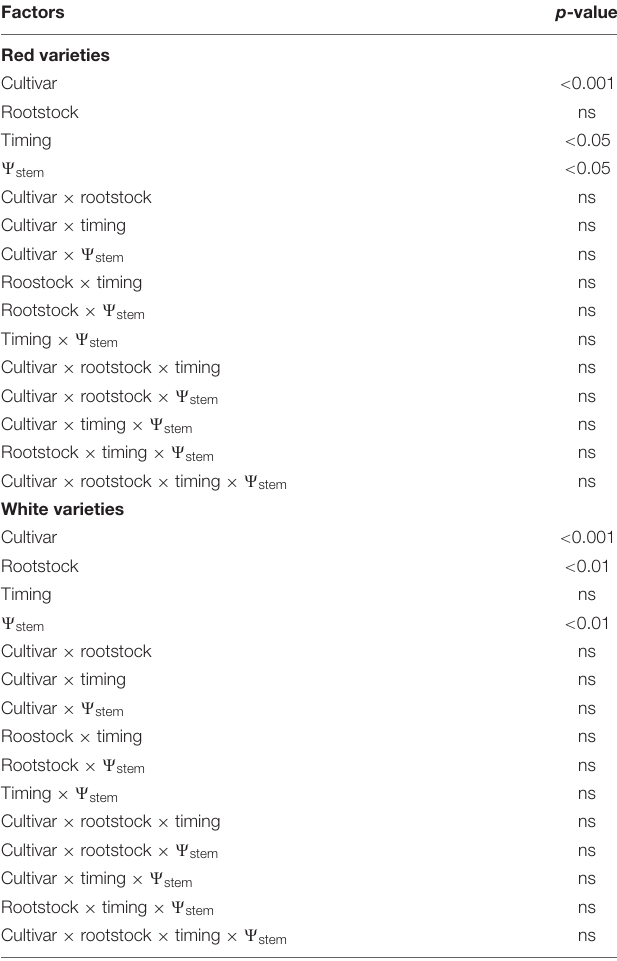
TABLE 1 | Factors included in the first univariate general linear model performed on the red and white varieties